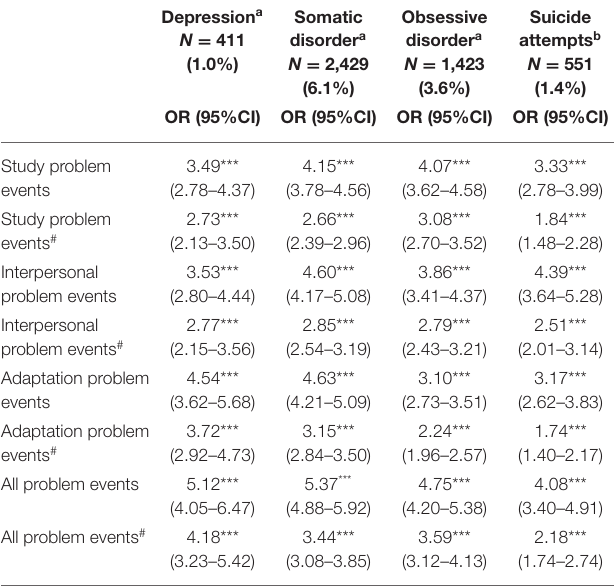
TABLE 4 | Independent associations between stressful problems/events and psychiatric morbidity ( N = 39,573). Depression